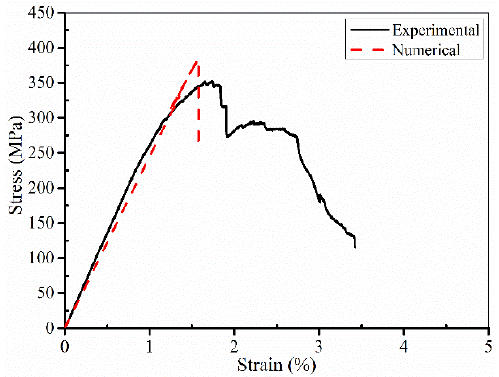
Figure 15. Comparison of SMAHC laminates between simulation and experimental.